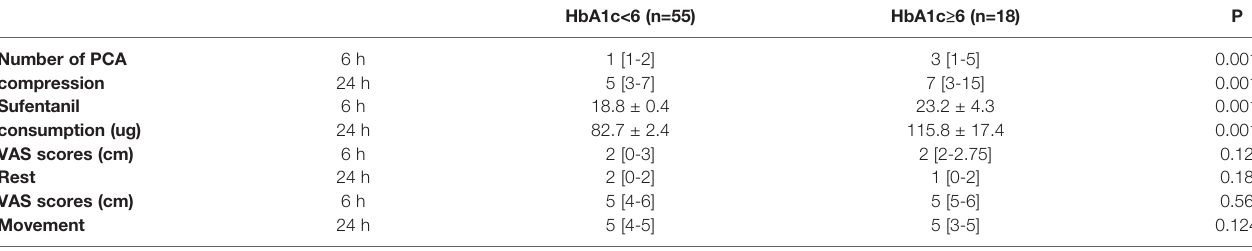
TABLE 2 | Postoperative analgesia.